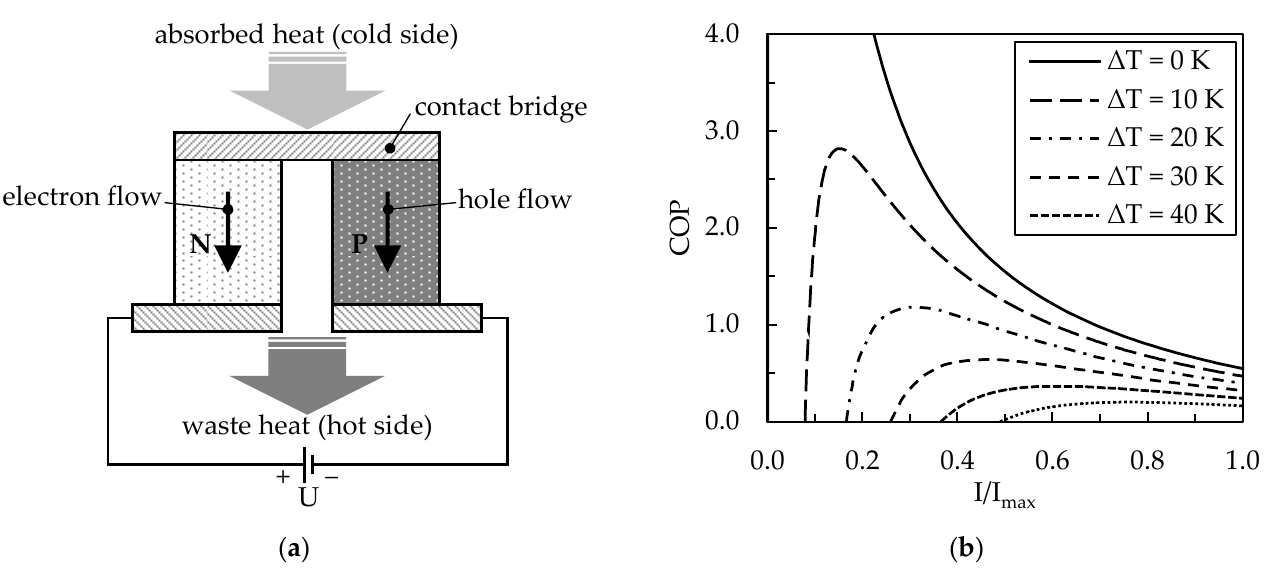
Figure 8. ( a ) Thermoelectric leg pair; ( b ) Coefficient of performance versus supply current in dependence of temperature difference [35].